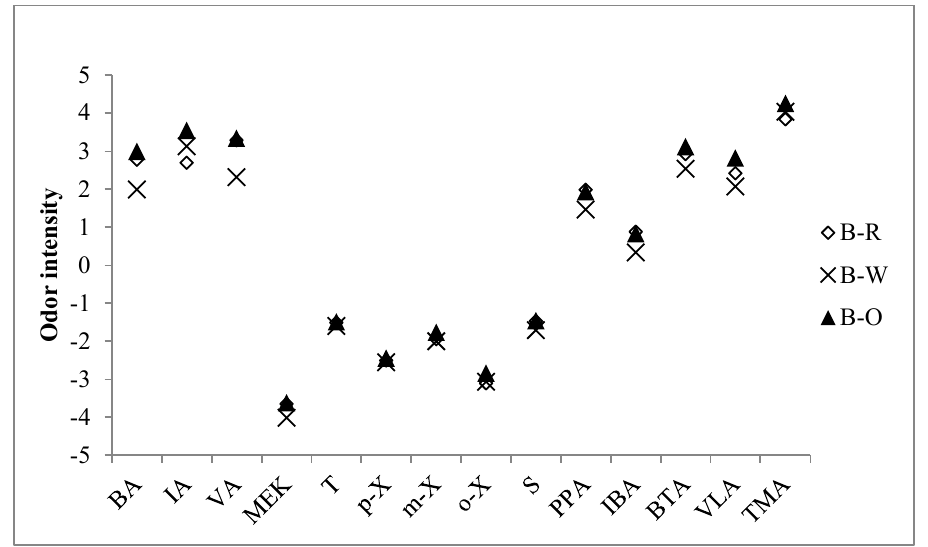
Figure 4. Comparison of odor intensity (OI) values of target compounds measured at different cooking stages (bag sampling).